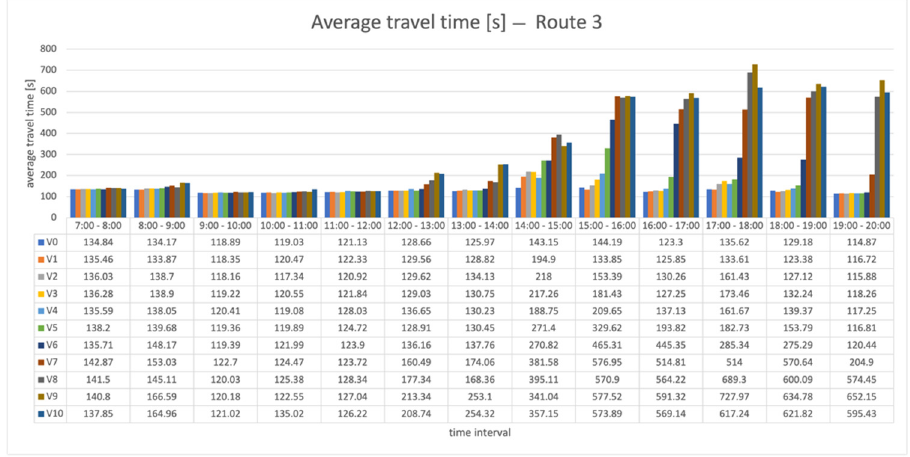
Figure 10. Average travel time; Section 3—all